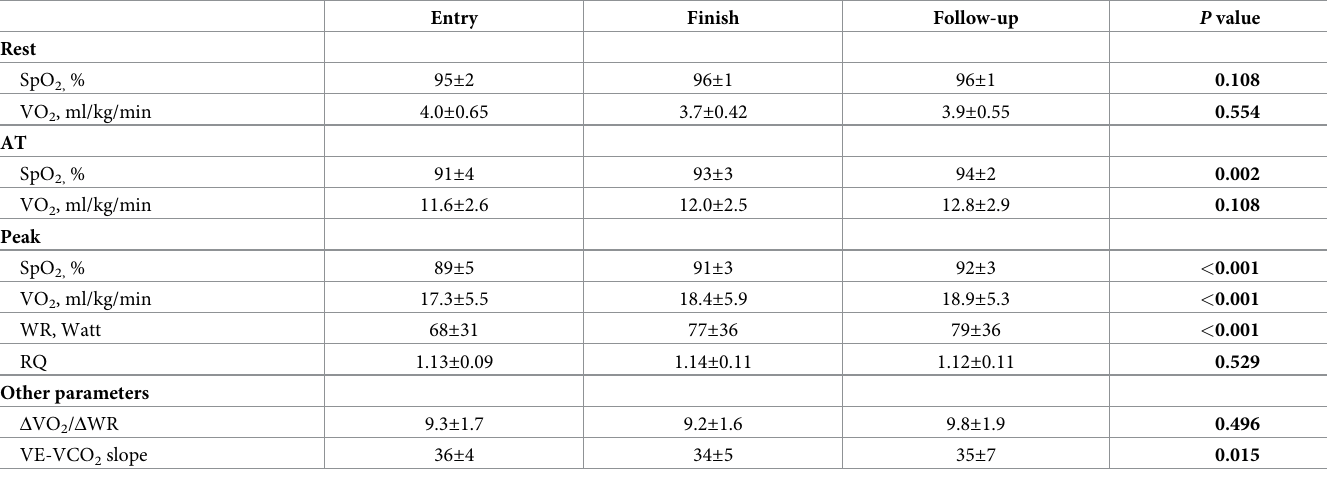
Table 4. Trend of parameters of cardiopulmonary exercise test.